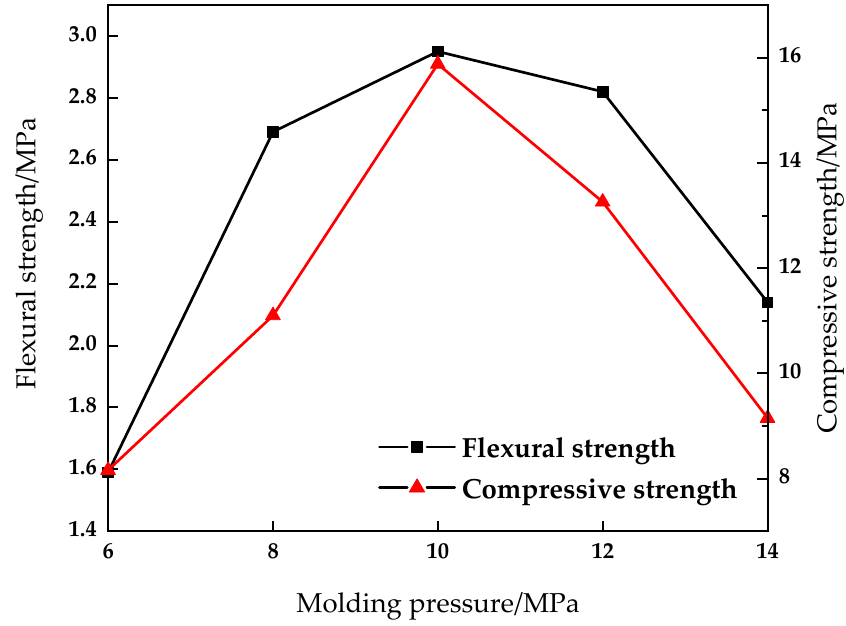
Figure 7. Effect of molding pressure on compressive and flexural properties of sintered brick.